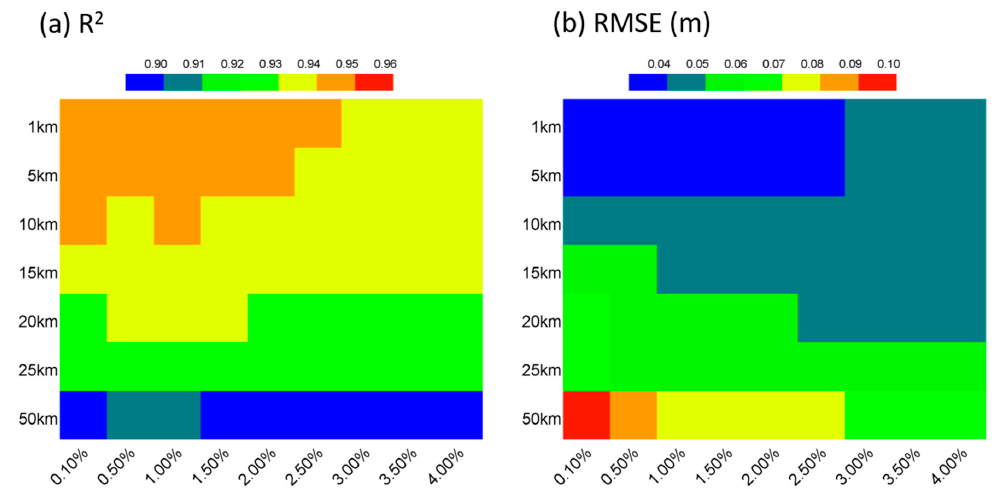
Figure 9. The R 2 ( a ) and RMSE (m) ( b ) for all the tracks combined between retrievals from the lowest elevation method and retrievals from the DMS method (ground truth) at 7 segment length scales: 1, 5, 10, 15, 20, 25, and 50 km, for 9 percentage scales: 0.1%, 0.5%, 1%, 1.5%, 2%, 2.5%, 3%, 3.5%, and 4% (the x-axis).